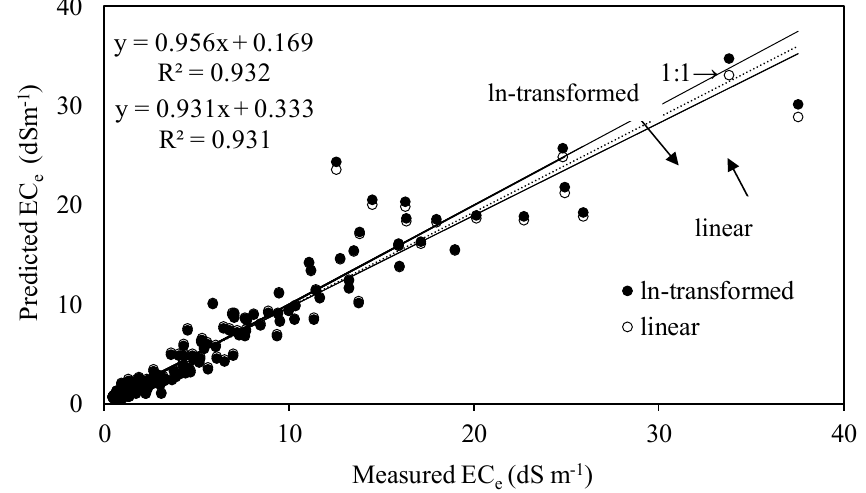
Figure 4. The relationships between the measured EC e values and the estimated EC e values from the ln-transformed model (Pred EC e = 0.956EC e + 0.169) and the linear expression (Pred EC e = 0.931EC e + 0.333) (N = 198).